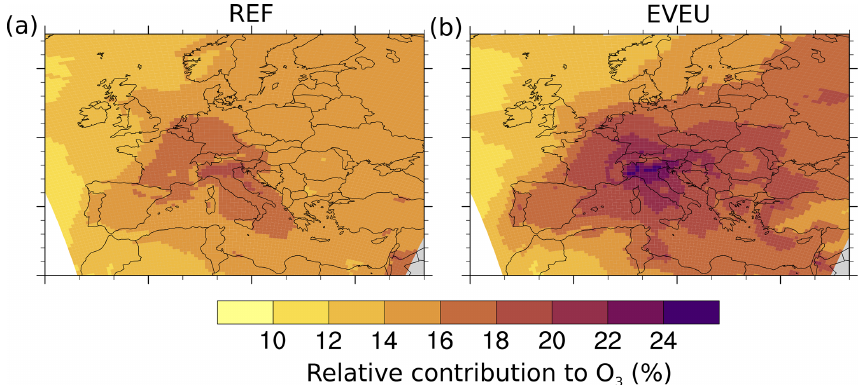
Figure 10. 95th percentile of the relative contribution of O tra and (b) are contributions for JJA of the REF and EVEU simulations, respectively.